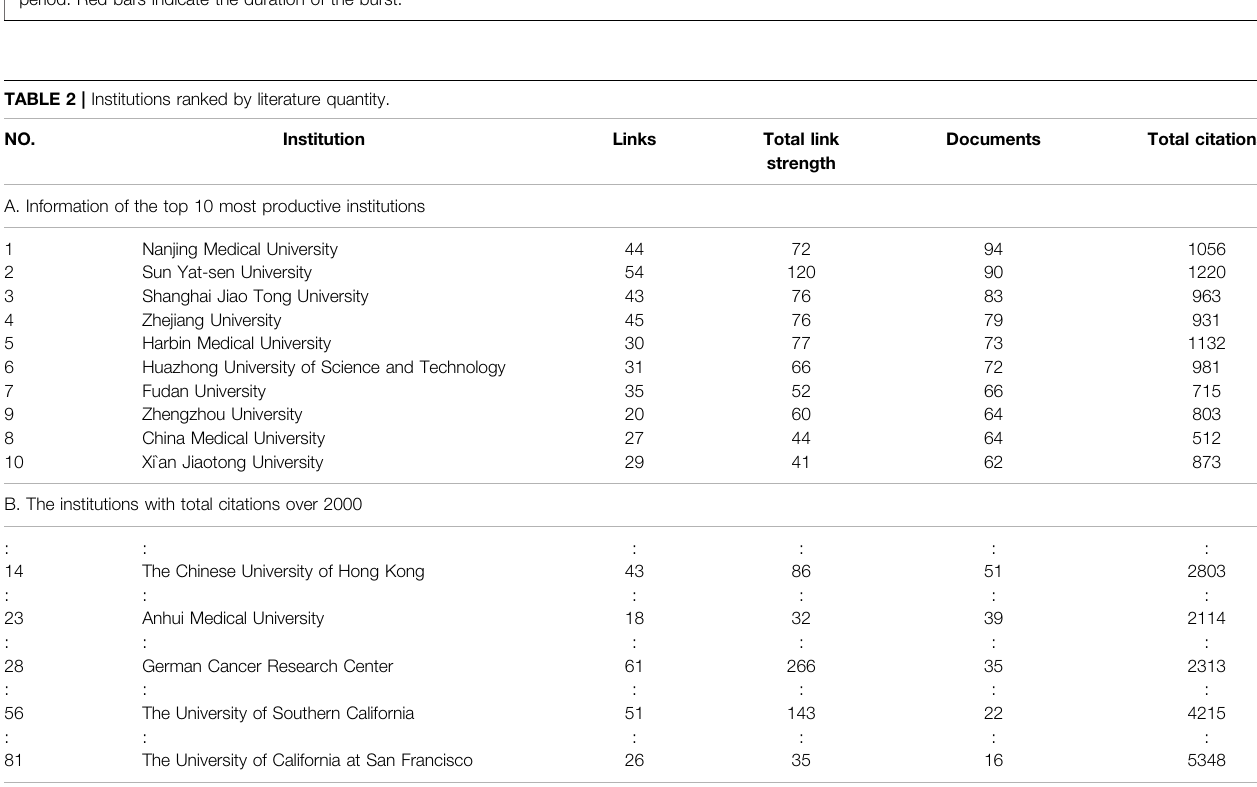
FIGURE 4 | Top fi ve countries/regions with the strongest citation bursts. Footnote: The strongest citation burst means that a variable changes greatly in a short period. Red bars indicate the duration of the burst.